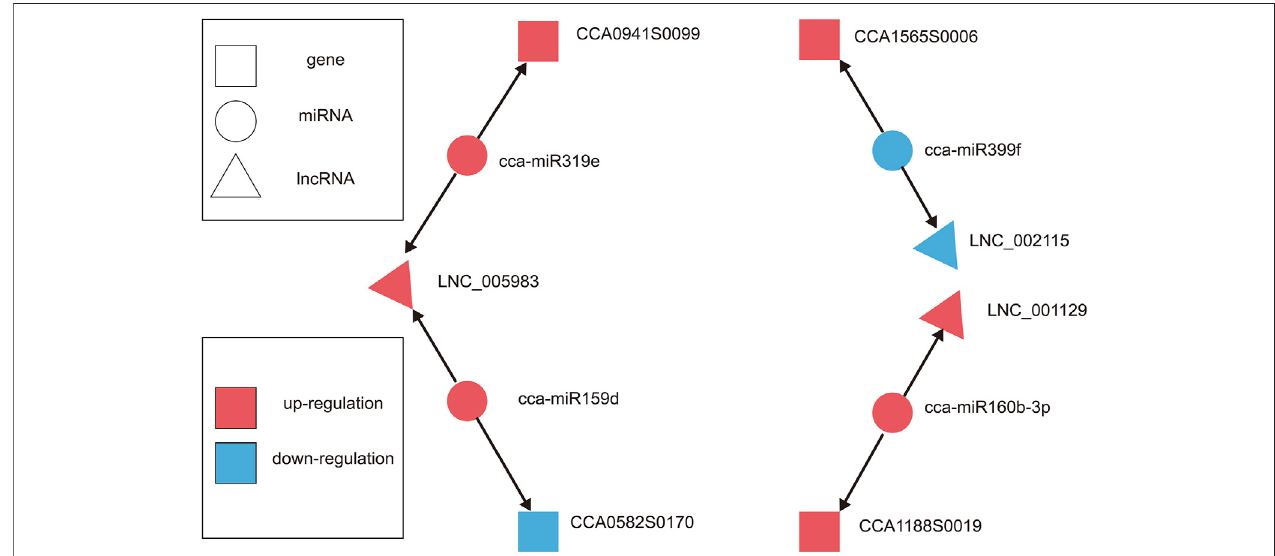
FIGURE 8 | The hypothesized lncRNAs-miRNAs-gene expression interaction ceRNA network of hickory female fl oral development in C1vsC2. The triangle, circle, and square nodes denote lncRNAs, miRNAs, and genes, respectively. The miRNAs could affect the expression of lncRNAs and genes. The cca-miR159d and cca- miR319e affected the expression of LNC_005983, while the expression of CCA0941S0099 was promoted by cca-miR319e; CCA0582S170 expression was inhibited by cca-miR159d. There was also cca-miR399f, which positively regulated LNC_002115 but negatively regulated CCA1565S0006, while cca-miR160b-3p positively regulated lncRNA and gene. The red denotes up-regulation and the blue denotes down-regulation.